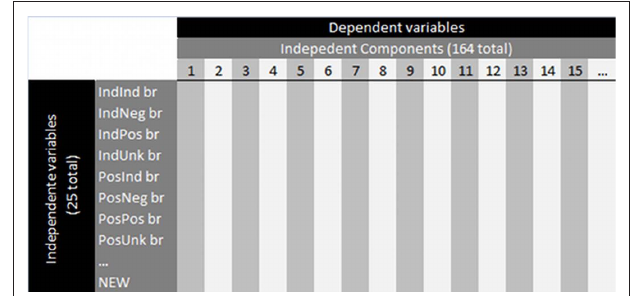
FIguRe 3 | Illustration of the application of a gLM analysis to each of the 164 independent components yielded by MeLODIC. For each IC, 25 independent variables were modeled: the three types of stimulus (positive, indifferent, and fictitious logos), times the four possible ratings (positive, indifferent, negative, and unknown), times the two epochs (before and after button pressing), and the non-emotional